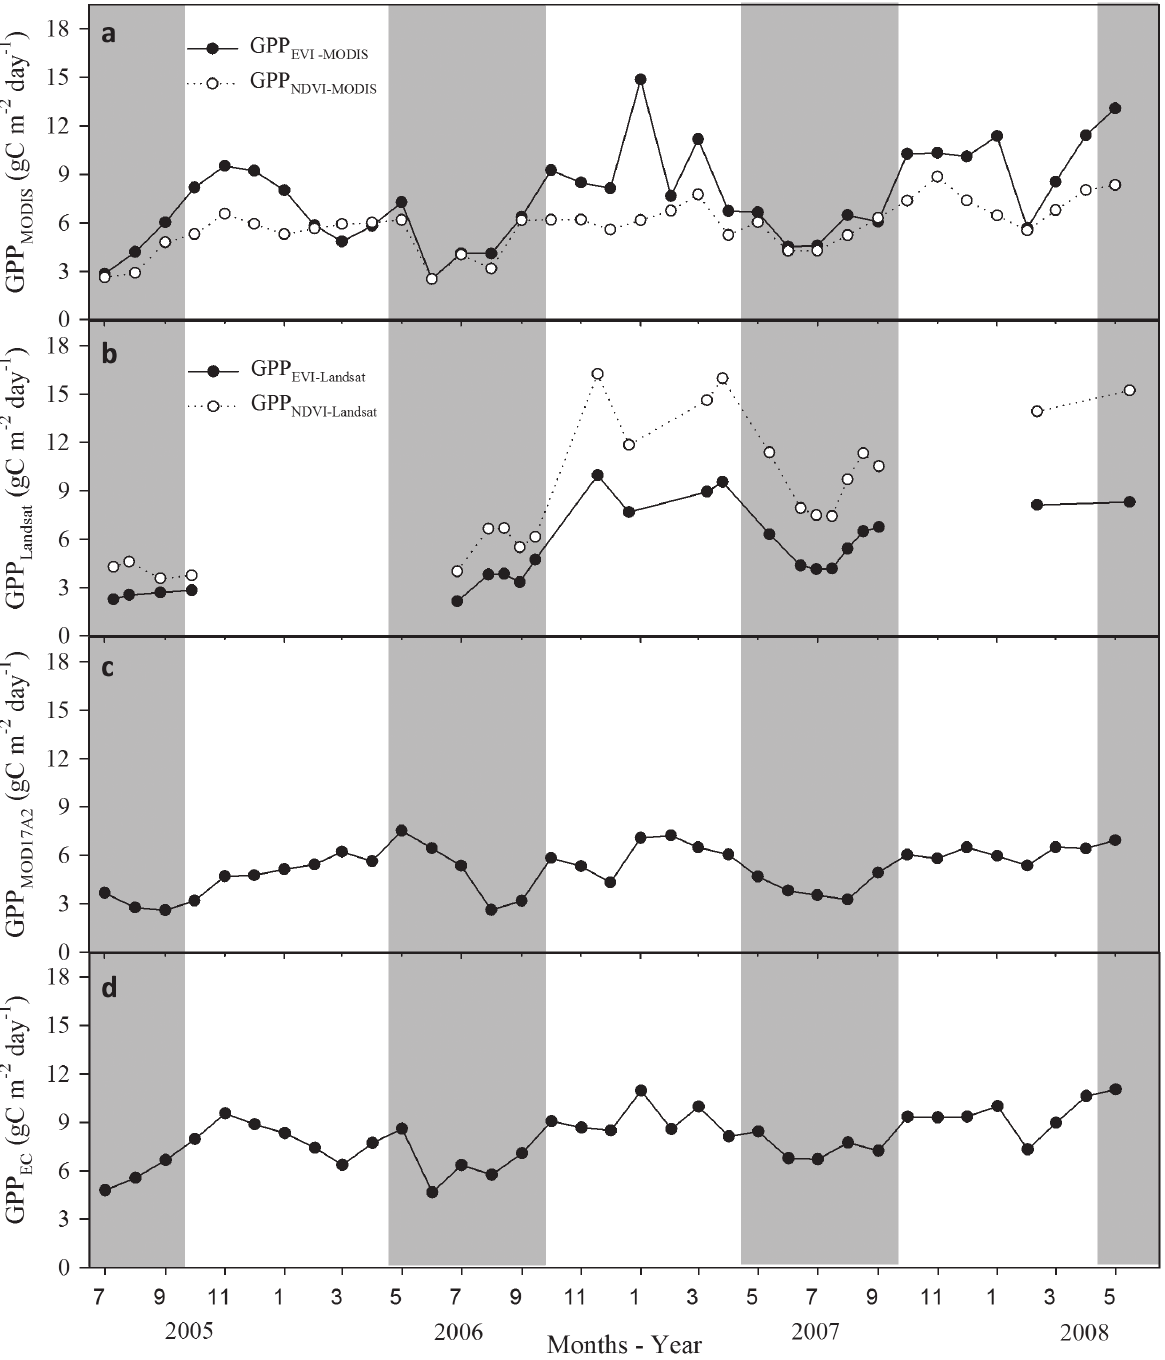
Fig. 4 - Monthly average of Gross Primary Production (gC m -2 day -1 ) estimated from Vegetation Photosynthesis Model (VPM) using Enhanced Vegetation Index (EVI) and Normalized Difference Vegetation Index (NDVI) calculated from Moderate Resolution Imaging Spectroradiometer (MODIS) (a) , using EVI and NDVI calculated from Landsat 5 TM (b) , estimated by MOD17A2 MODIS GPP Product (c) and measured by eddy covariance (d) in the Amazon-Cerrado transitional forest from July 2005 to June 2008. The gray vertical column represents the dry